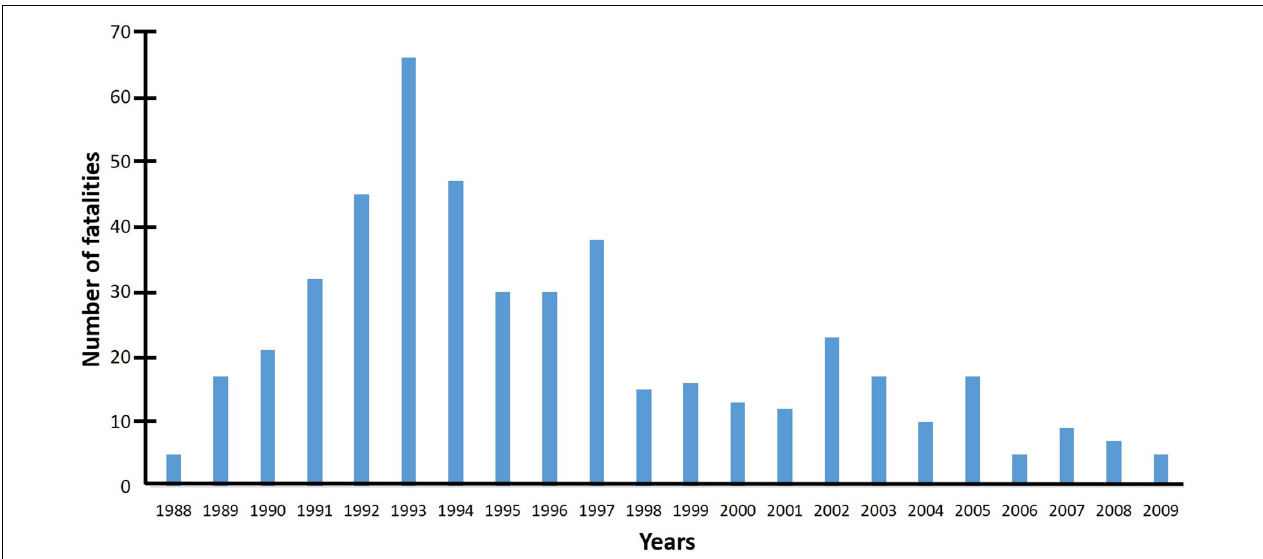
FIGURE 6 | Number of death people from honey bee stings in Mexico between 1988 and 2009 (data from Becerril-Ángeles et al., 2013). By comparison, the probability of being killed by honey bee stinging incidents in Mexico is about 12 times lower than the probability of being killed by scorpion stinging